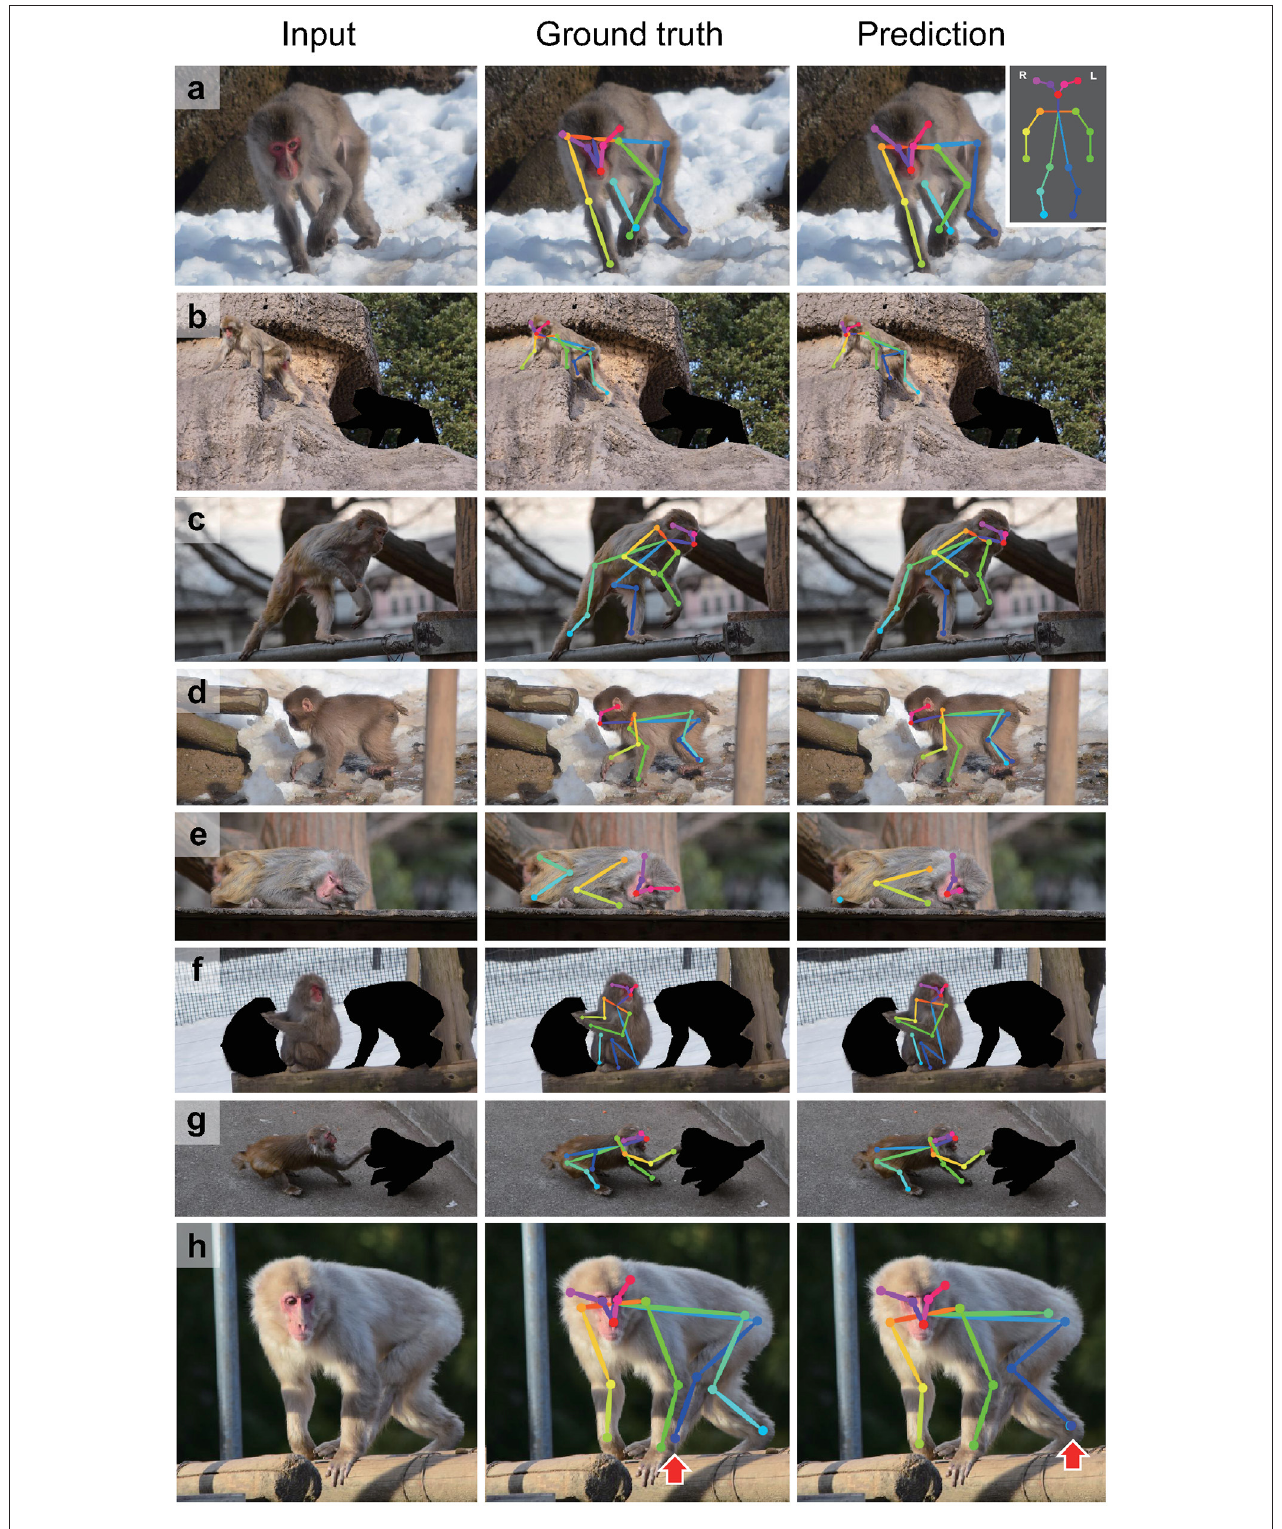
FIGURE 2 | Examples of test image predictions. Test images (left), the ground truth keypoint positions (center) and the position predicted by the artificial neural network trained with the present dataset using the DeepLabCut algorithm (right; a–h ). The inset (top right corner) shows color codes of the keypoints. Red arrows in (h) indicate a misattribution